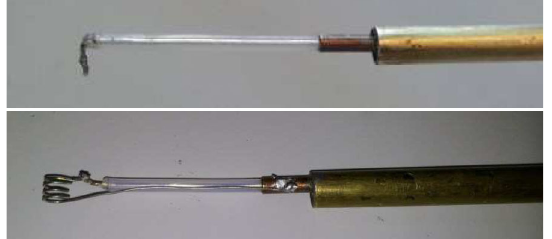
FIG. 8. Probe with bent termination (top) and probe with straight termination (bottom) on which has been mounted a loop.